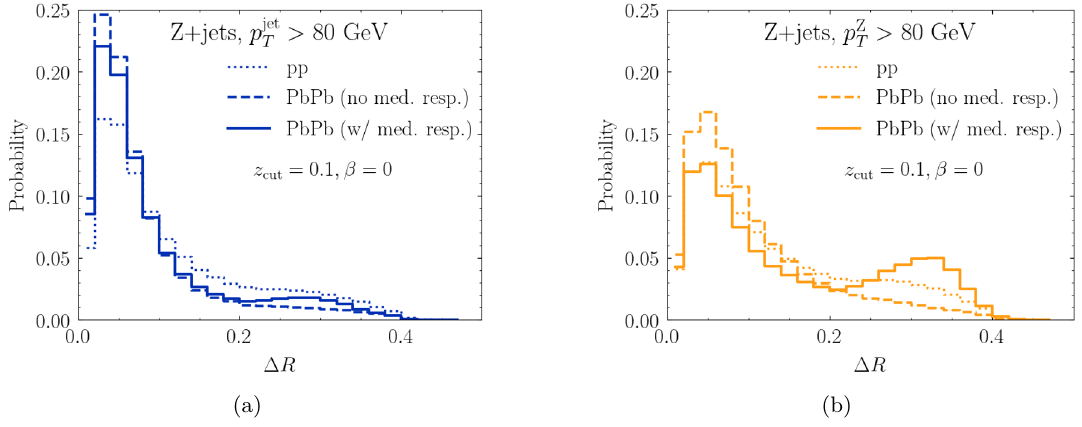
Figure 5. ∆ R distributions, (a, blue curves) for jets with p T above 80 GeV in Z +jet events and (b, orange curves) for jets in events containing a Z boson with p T above 80 GeV. We show these distributions for Z +jet events in vacuum (dotted), in heavy ion collisions with hadrons coming from the wake that the jet deposits in the droplet of quark-gluon plasma artificially excluded (dashed), and in heavy ion collisions including hadrons coming from the response of the medium that are reconstructed as a part of the jets